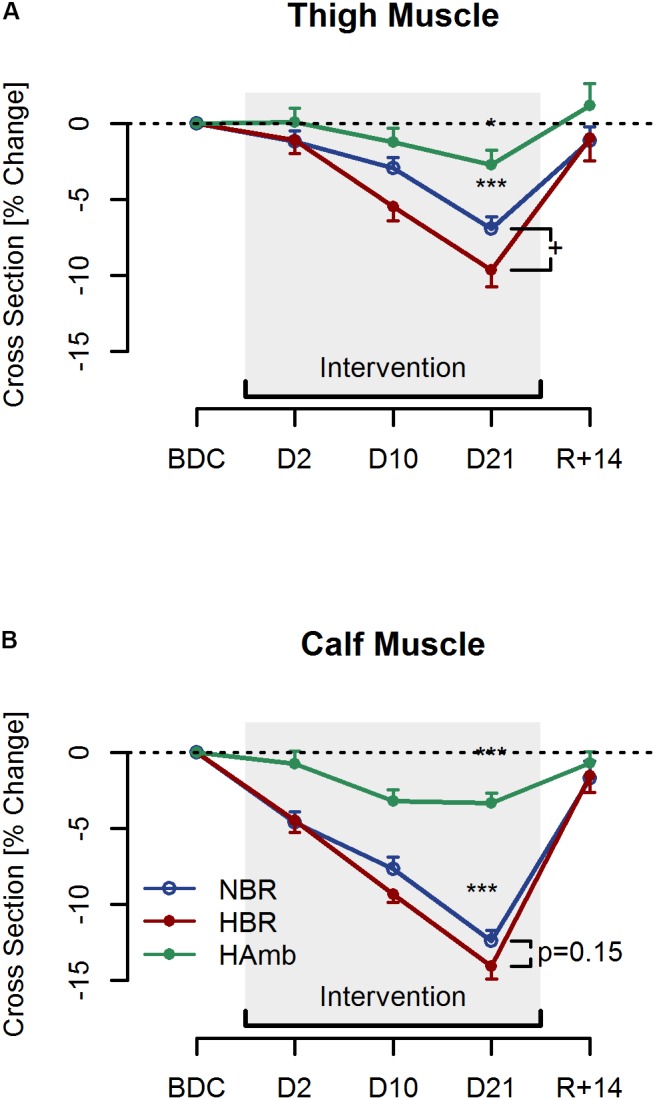
Thigh (A) and Calf (B) muscle cross-sectional area changes after two (D2), ten (D10), and twenty-one (D21) days of normoxic bed rest (NBR; blue), hypoxic bed rest (HBR; red) and hypoxic ambulation (HAmb; green) interventions, as well as 14 days post (R+14). Data are presented as Means ± SE. ∗(p < 0.05) and ∗∗∗(p < 0.001) denote significant reductions compared to baseline. + (p < 0.05) denotes significant difference between the two bed rest interventions.